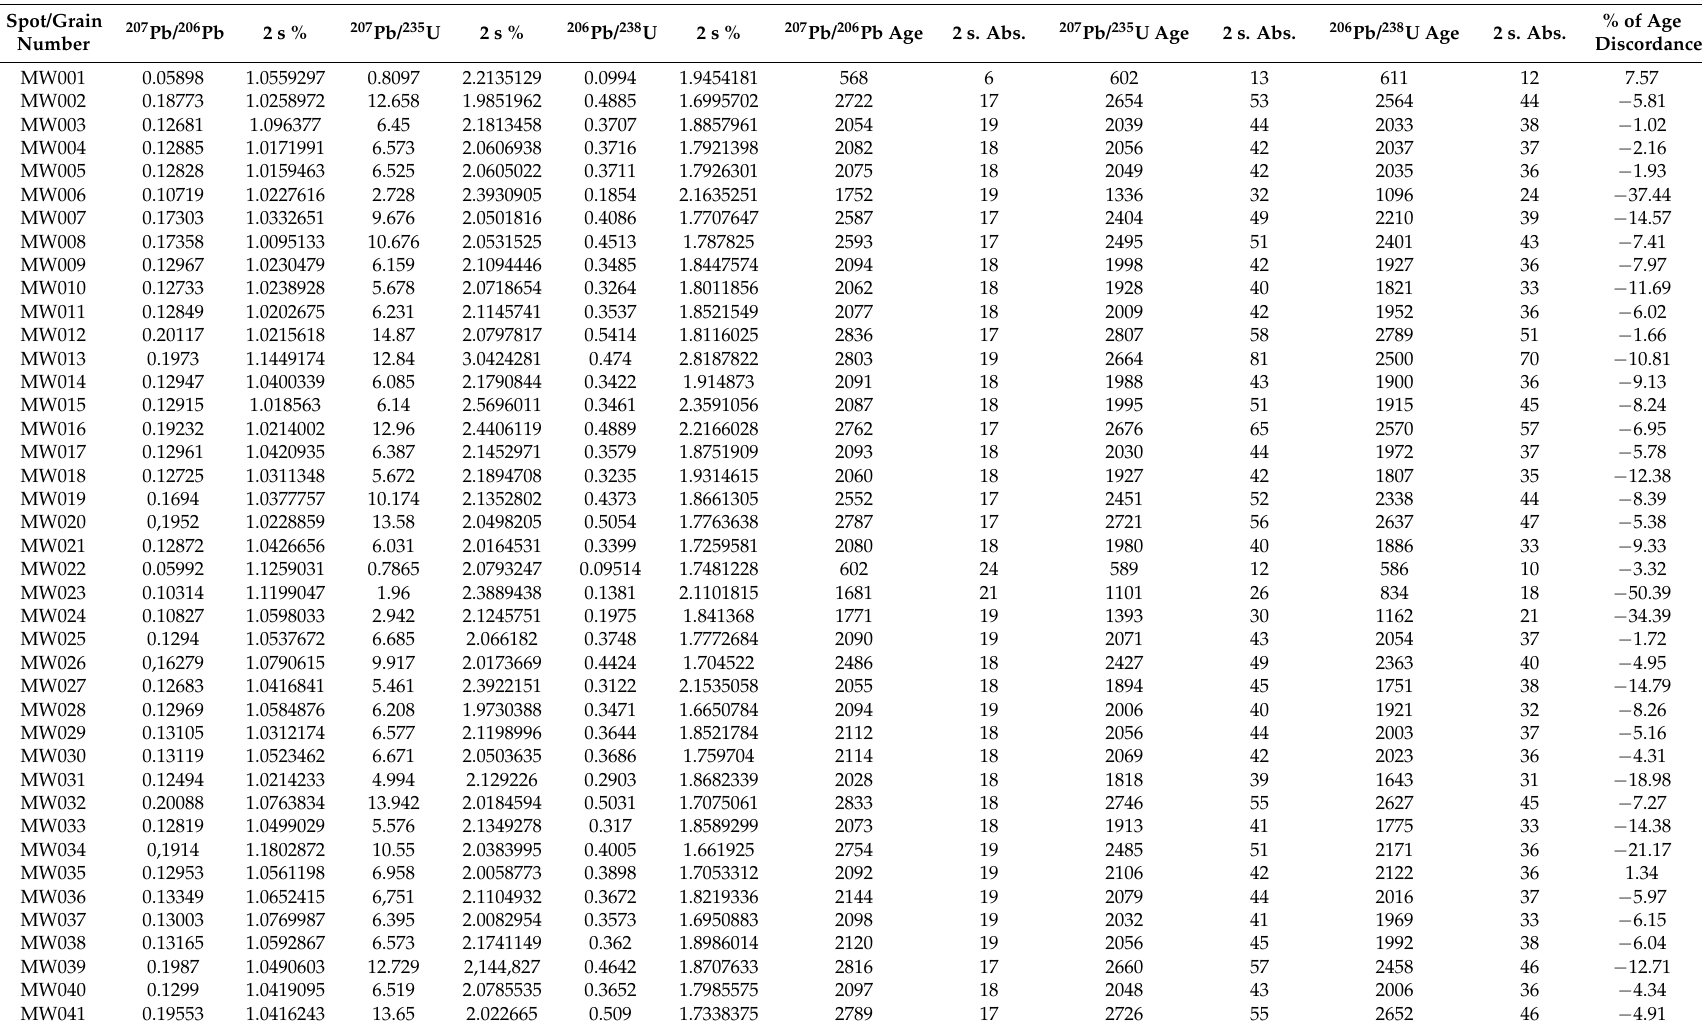
Table 3. Isotopic geochemical data and U–Pb core age (in Ma) for the west Meiganga detrital